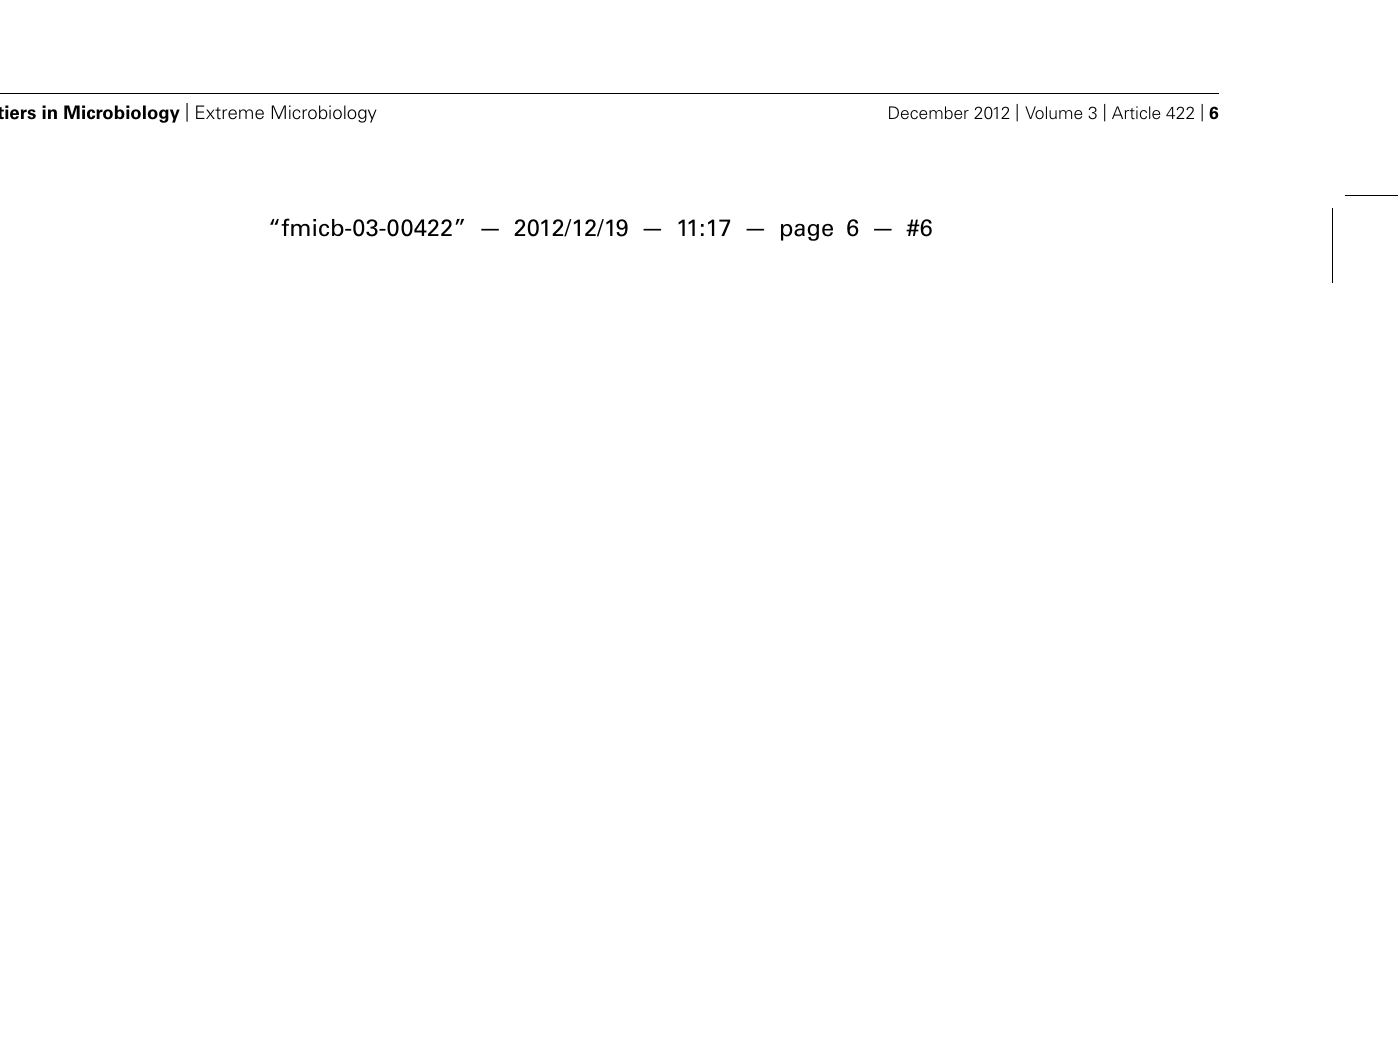
CercozoaTelonemaFungiCryptophytesChlorophytesCiliatesMALVsChrysophytesDiatomsMASTsHaptophytes